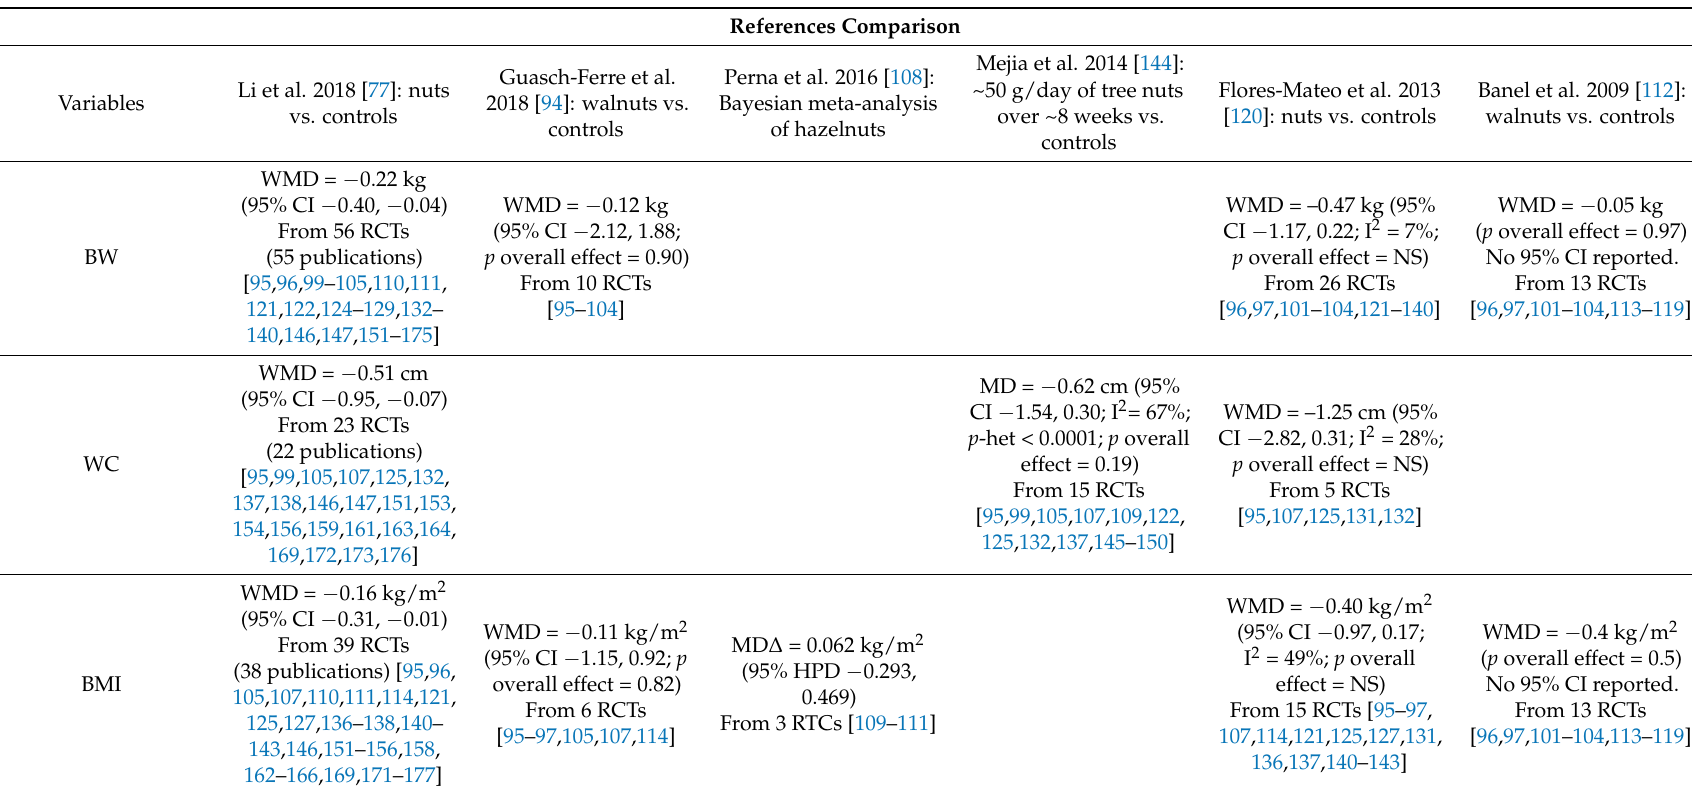
Table 3. Summary of nut consumption and anthropometric parameters in intervention